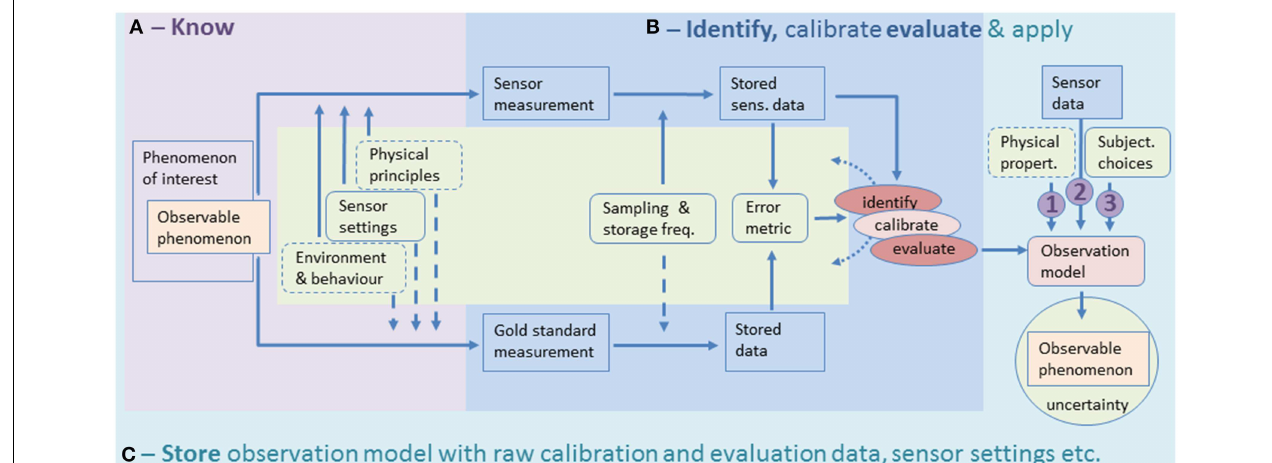
the development of an observation model goes through two main cycles: identification of the model structure and best possible parameter values (calibration is a final step in this) and evaluation of the derived model on independent data. Identification and Evaluation are steps two and three in the 4-step workflow and are highlighted in the blue area (B) of the figure. The processes of identification, calibration and evaluation typically require several experiments, hence the dotted arrows link back into the green box. After an observation model passes the evaluation, it can be applied to predict an observable phenomenon (with associated uncertainty) on the basis of sensor data. The final step in the workflow is then to store the result of the identification and evaluation experiments (C) . The fact that this box encloses all the components of the figure emphasizes that this storage should include all relevant contextual information, modeling choices, sensor settings (etc.) along with the observation model, and should also link to application studies where this particular observation model has been used. The three encircled numbers in the model-application part at the right highlight the three main concepts to classify ABT error: (1) the basic physical properties underlying data collection; (2) the conversion of raw data into useful variables; and (3) the subjectivity in the selected settings. These concepts can only be adequately quantified if the entire workflow is rigorously applied.